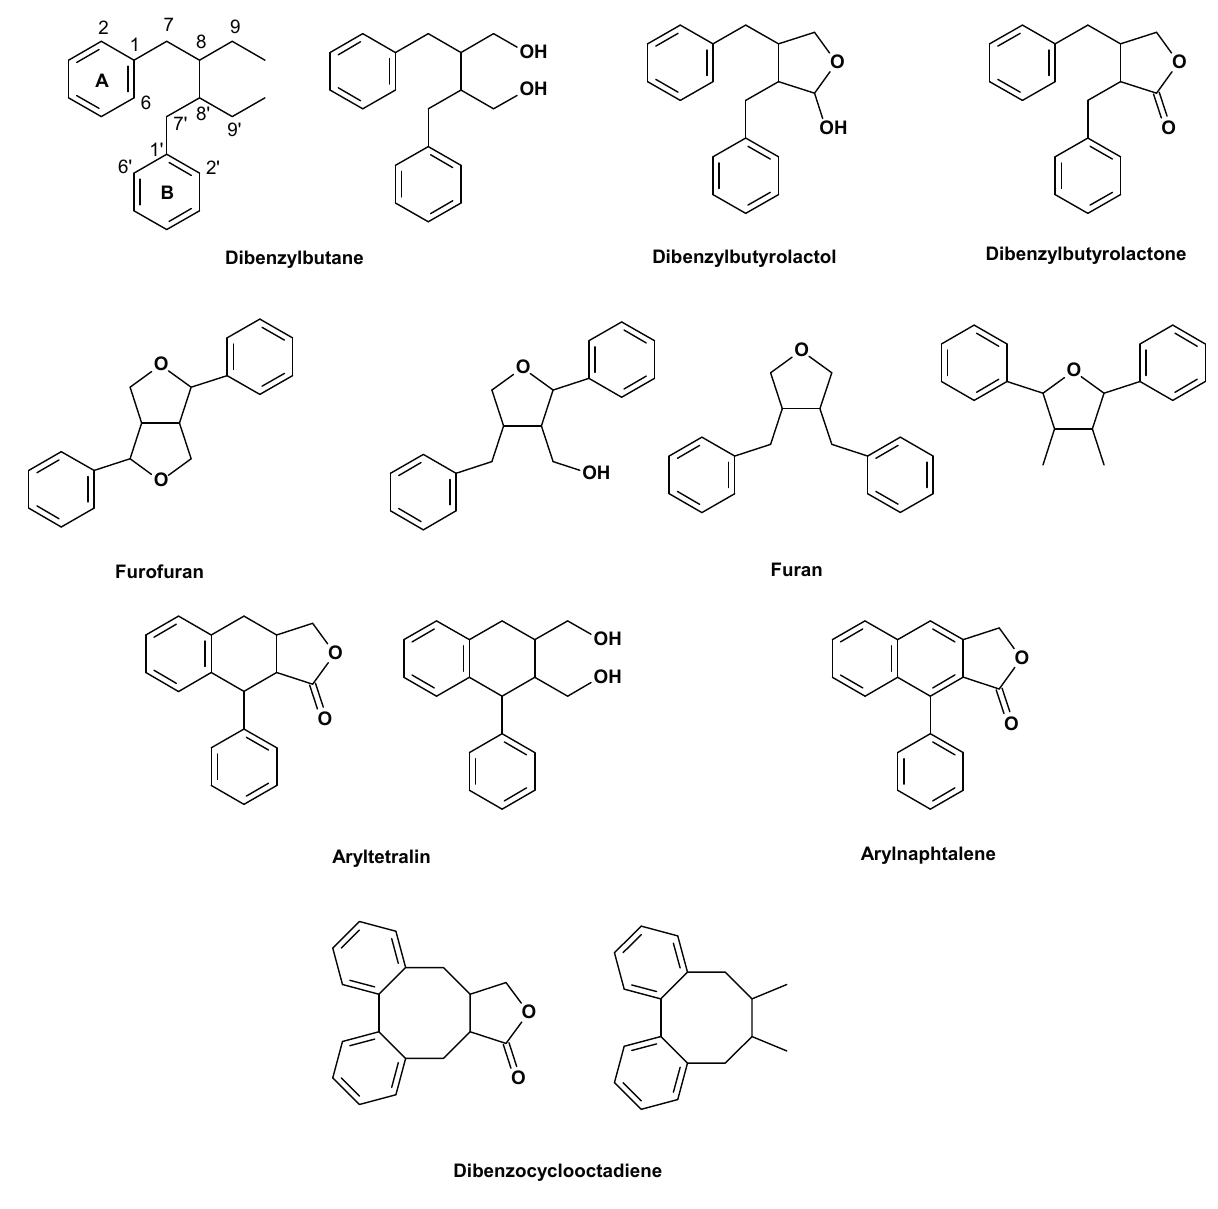
Figure 1. General classes of